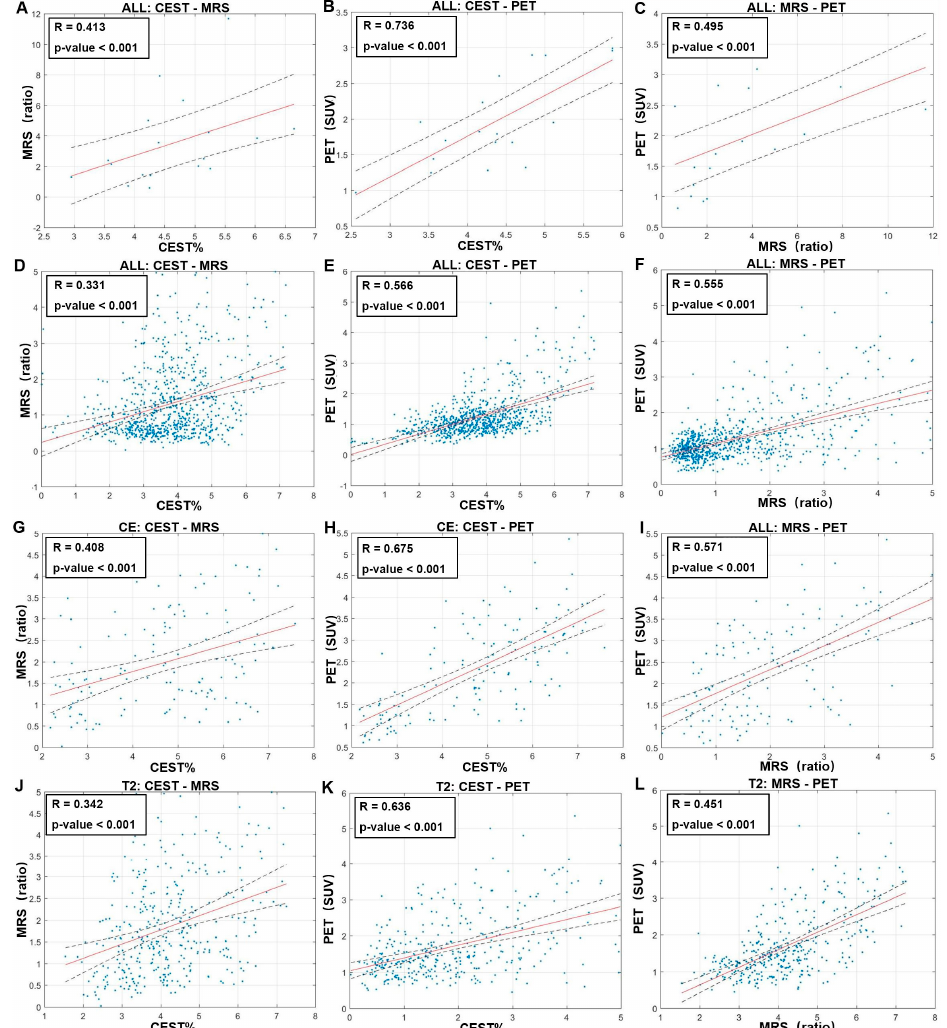
Figure 2. Correlations between APT-CEST, MRS and FET-PET. Patient-wise correlations of CEST − MRS ( A ), CEST − FET ( B ) and MRS − FET ( C ) in all regions; voxel-wise correlations of CEST − MRS ( D ), CEST − FET ( E ) and MRS − FET ( F ) in all regions. Correlations of CEST − MRS ( G ), CEST − FET (H) and MRS − FET ( I ) in voxels of contrast-enhanced regions; correlations of CEST − MRS ( J ), CEST − FET ( K ) and MRS − FET ( L ) in voxels of T2 − hyperintense